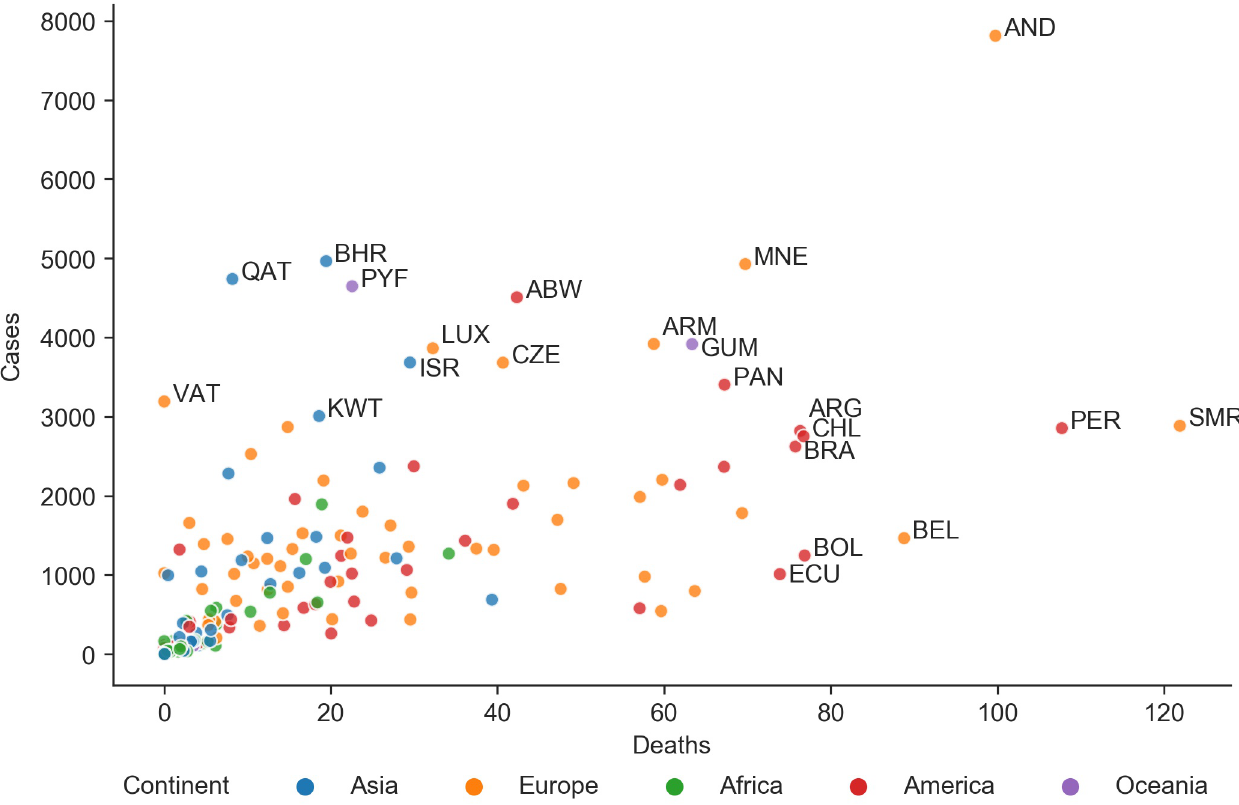
Figure 15. Cases vs. deaths: Accumulated deaths vs. cases (per 100,000 of the population) in the different countries studied.